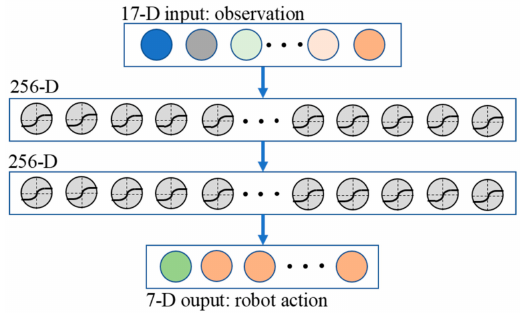
Figure 4. Network architecture used for gait policy is a two-layer MLP with tanh activation function. The input is the observation vector of the agent. The output is an extremely simple 7D